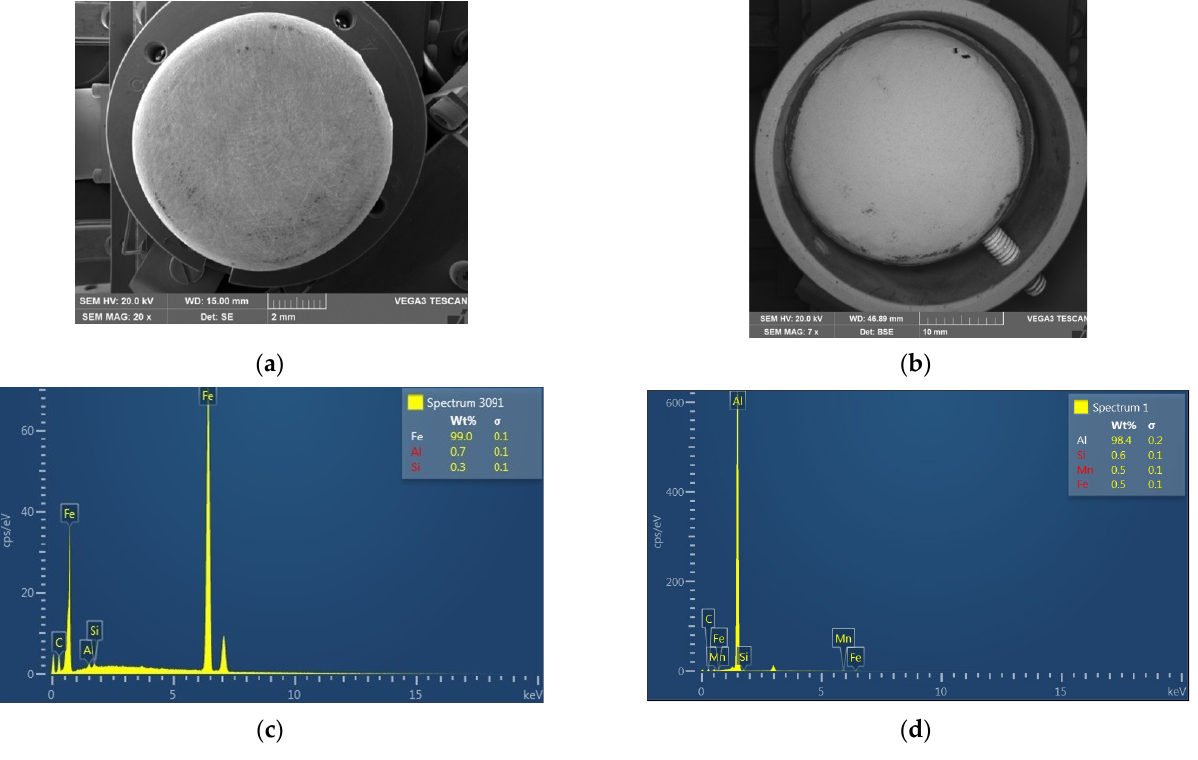
Figure 3. SEM images ( a , b ) and elemental compositions ( c , d ) of the Metal 1 ( a , c ) and Metal 2 ( b , d )